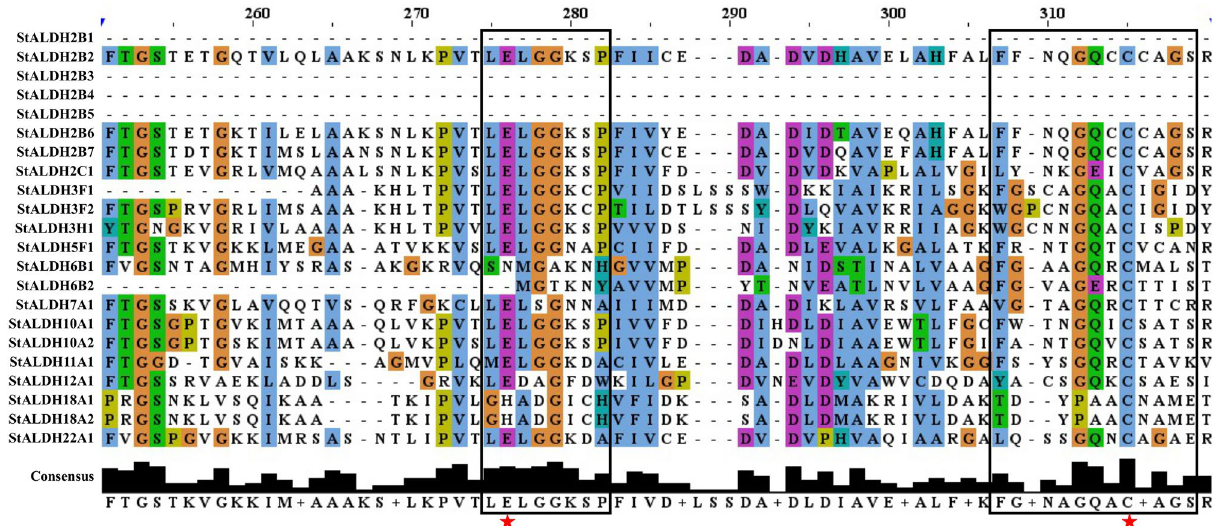
Figure 1. Sequence alignment of the ALDH domain of all the identified StALDH proteins. The ALDH conserved domain (PF00171) of all the putative StALDH proteins were analyzed to identify the conserved